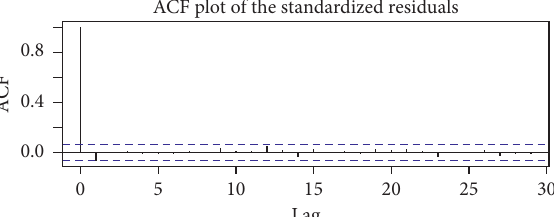
Figure 2: Autocorrelation plot of resulting residuals.